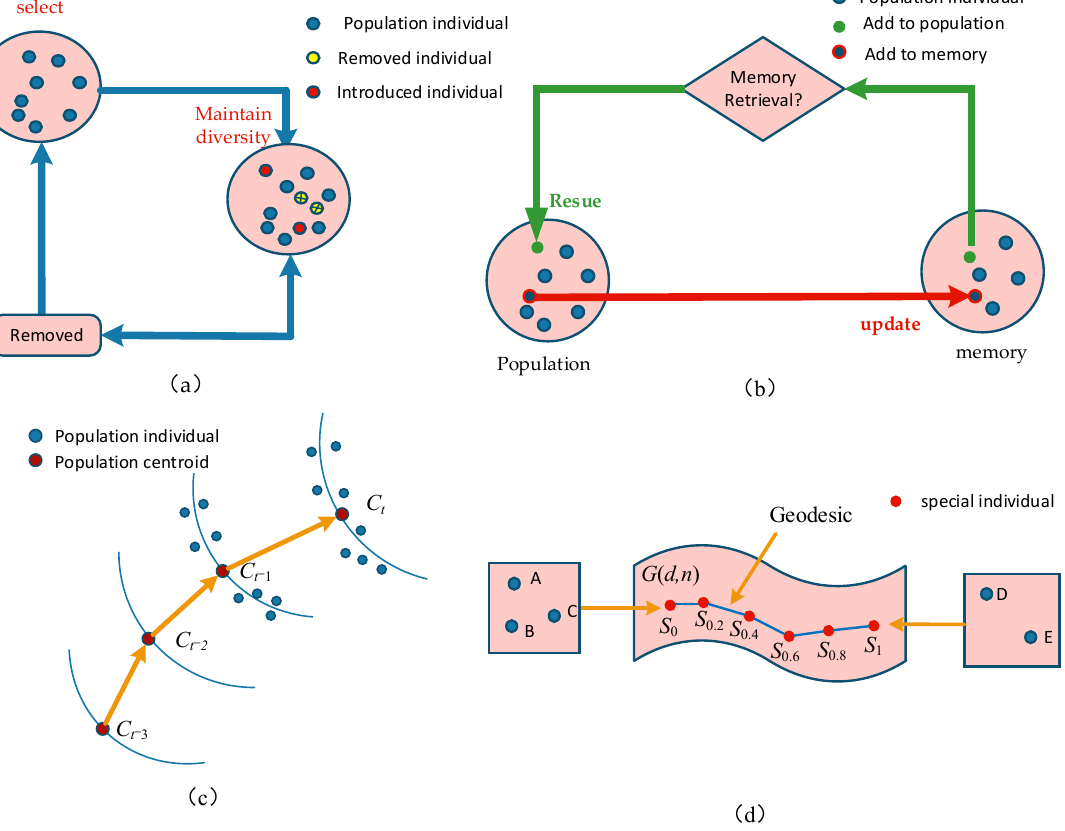
Figure 1. Description of environmental response strategies and methods. ( a ) diversity maintenance. ( b ) Memory based approach. ( c ) Prediction based approach ( d ) Manifold transfer learning method.